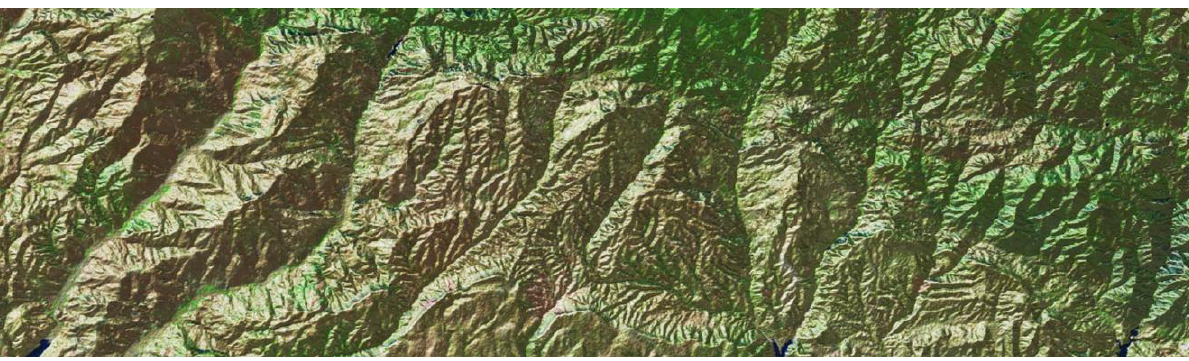
Figure 7. Connection of NASA_P image with SRTM-1. Full resolution reduced 2x to show greater